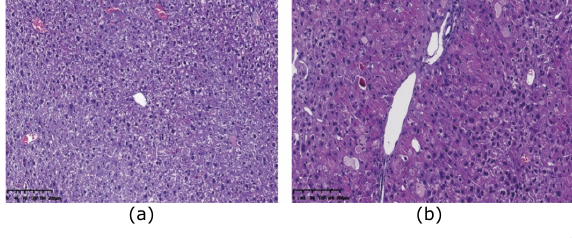
Figure 3 - Gynura segetum induced the changes of histopathology with hematoxylin and eosin staining in mice (n = 10). Liver specimens were collected at five weeks after G. segetum administration, and liver sections were stained with hematoxylin-eosin staining. (a) control group; (b) G. segetum -induced group. Original magnification, ×100.